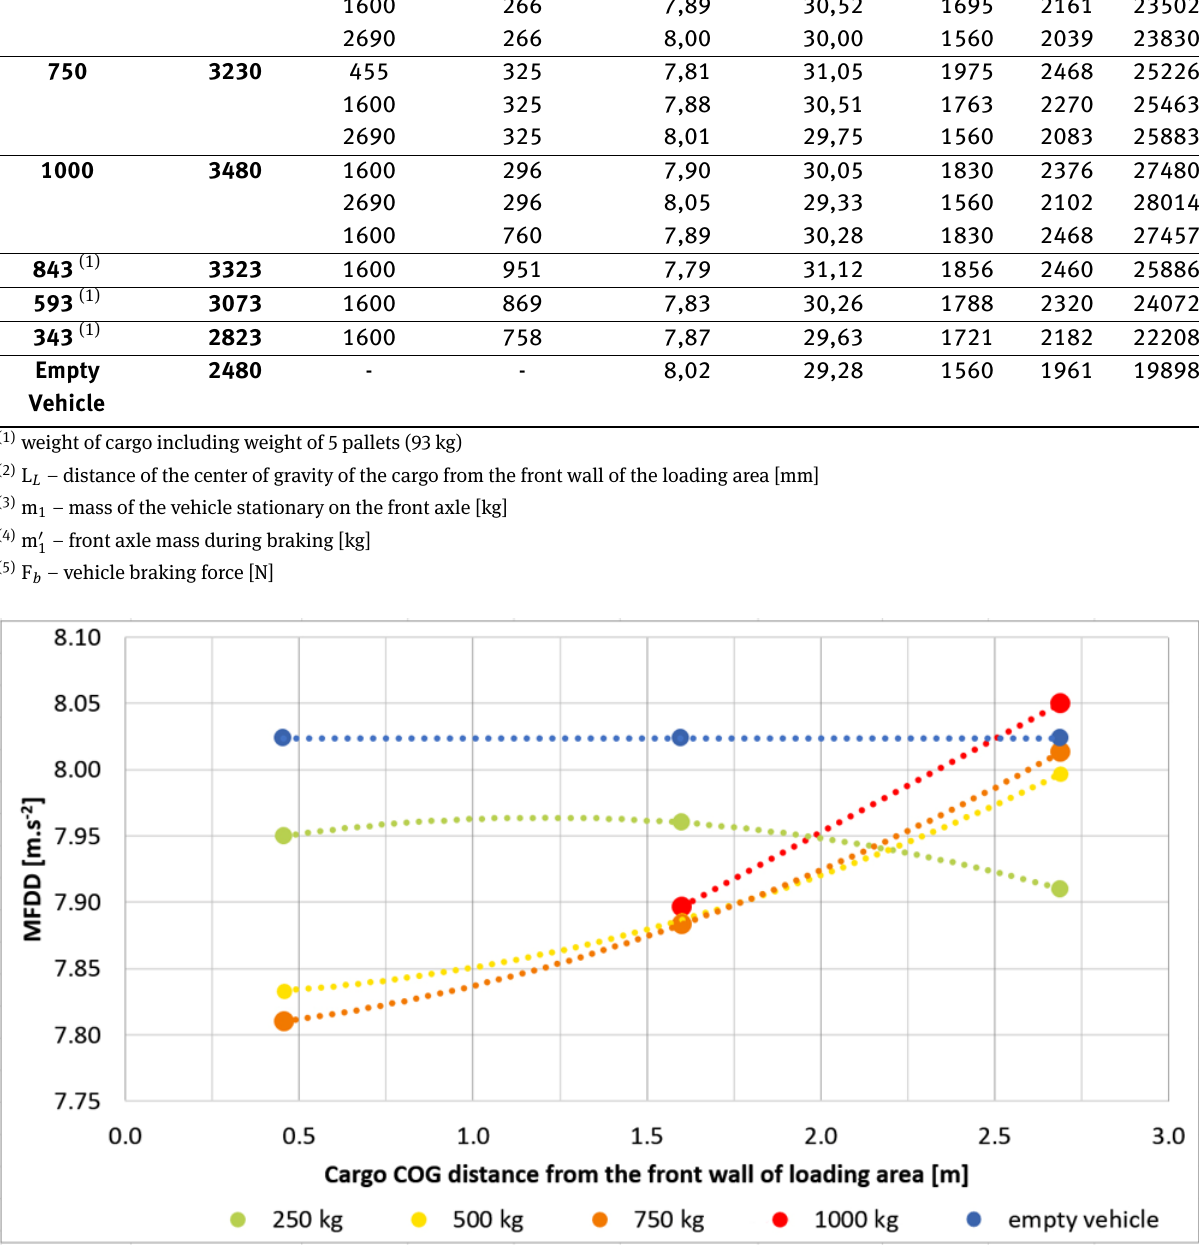
Figure 5: Influence of the cargo mass and its position on the floor on MFDD Source: